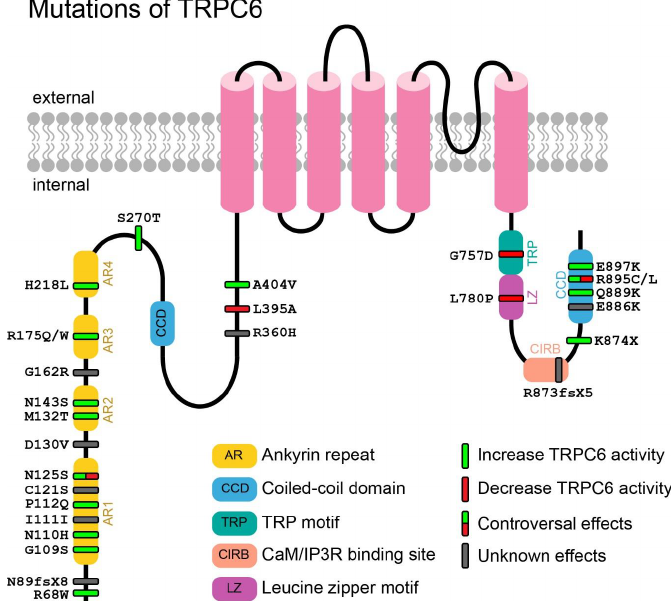
Figure 7. Mutations that cause changes in TRPC6 proteins. A cartoon depicting TRPC6 with its important motifs and mutations (missense substitution, frame shift and deletion). Mutations are presented in bars. Green bars denote GOF mutations, while red bars denote LOF mutations. Gray bars denote mutations with unknown effects (function of which has not been studied), while bars with half green and half red colors denote mutations with controversial effects (controversial reports are found). Mutations of TRPC6 can be classified into three categories, including synonymous (one site), missense (22 sites, the most case) and nonsense (three sites) mutations. At the mRNA level, these mutations are mainly located in exon 2 (15 sites) and 13 (seven sites). At the protein level, half of them are located in or near the ankyrin repeat region (13 sites) on the N-terminus, five sites in the coiled- coil domain on the C-terminus, two sites in or near the CIRB domain, one site in the TRP motif, and one site in the leucine zipper motif. Both the ankyrin repeat region and the coiled-coil domain are reported to be important for TRPC6 multimerization and interaction with other proteins [129–131], while the CIRB domain is critical for channel activity regulation involving CaM/IP 3 R [132–134]. The leucine zipper motif is also reported to be important for the regulation of TRPC6 [135]. In addition, the TRP motif, which is a highly conserved region among all TRP channels, is essential for TRP channel activation [135,136]. Sitting in these important domains, the reported mutations do change the properties of TRPC6 in terms of activity, kinetics, and subcellular location. G109S, N110H, Q889K, R895C, and E897K were reported to increase the basal activity of TRPC6 [137]; N143S, H218L and A404V augmented the maximum influx of Ca 2+ [137]; M132T, S270T and K874X caused delayed inactivation of TRPC6 [128,138]; R68W, P112Q enhanced the cell surface expression of the channel